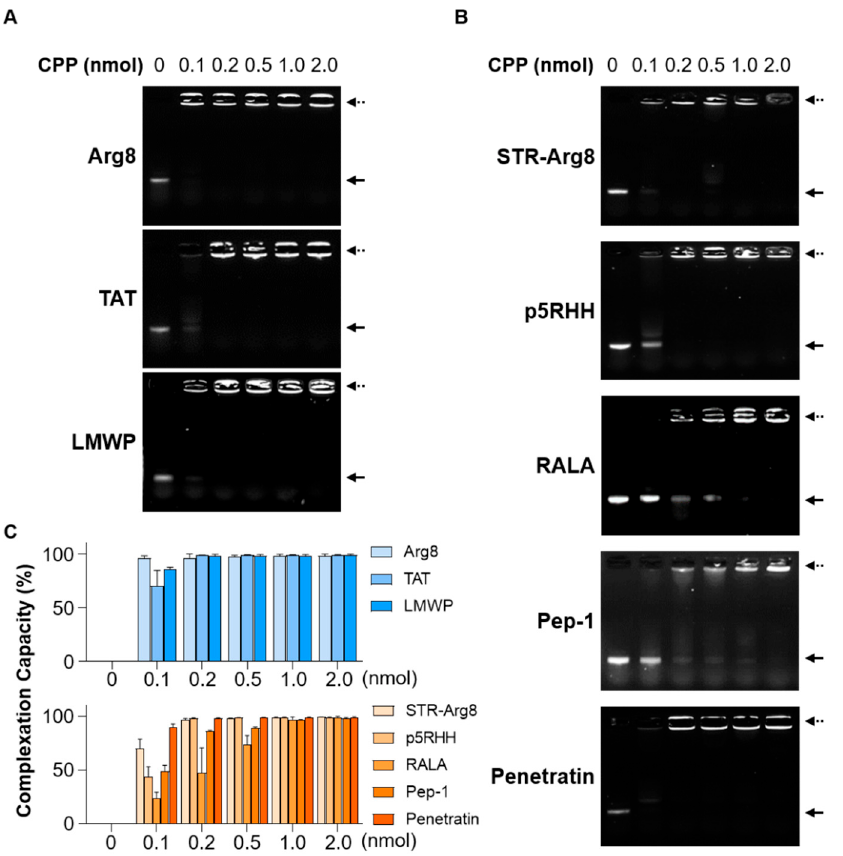
Figure 2. Formation of complexes between mRNA and CPPs. Representative agarose gel images showing mCherry mRNA (350 ng) complexed with the increasing amounts of cationic CPPs ( A ) and amphipathic CPPs ( B ). Solid arrow represents naked mCherry mRNA and dashed arrow represents CPP/mCherry mRNA complexes. ( C ) Complexation capacity of cationic (upper graph) and amphipathic (lower graph) CPPs based on mRNA band intensities. Data are presented as the mean ± SD ( n = 3). Table 2. Particle size, polydispersity index and zeta potential of CPP/mRNA